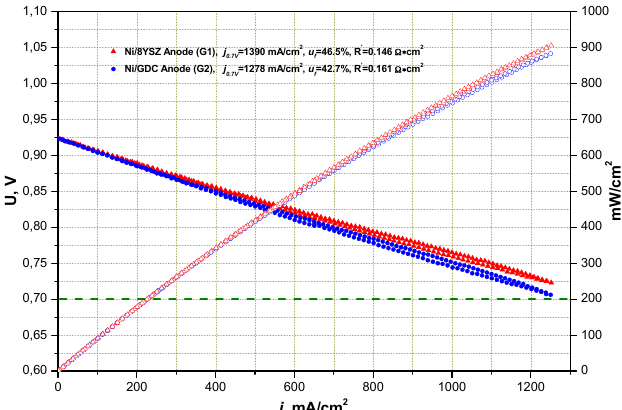
Figure 1. I–V characteristics of single cells with Ni/8YSZ and Ni/CGO electrodes at 850 °C in H 2 :H 2 O = 50:50 (R-values correspond to area specific resistance (ASR) corrected to the fuel utilization).